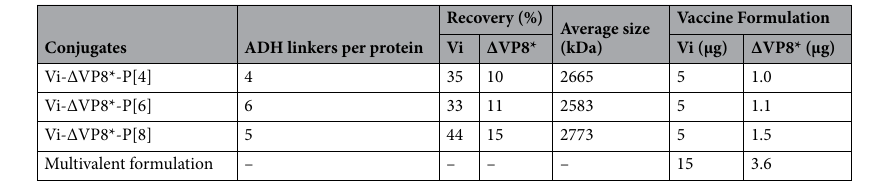
Table 1. Characterization of Vi-ΔVP8* conjugates. 1 Recovery of each conjugate obtained was calculated on the basis of Vi concentration and protein concentration. 2 Vi concentration was based on Hestrin assay. 3 ΔVP8* protein concentration was based on Bradford assay. 4 Multivalent formulation is the mixture of Vi-ΔVP8*-P[4], P[6], and P[8].